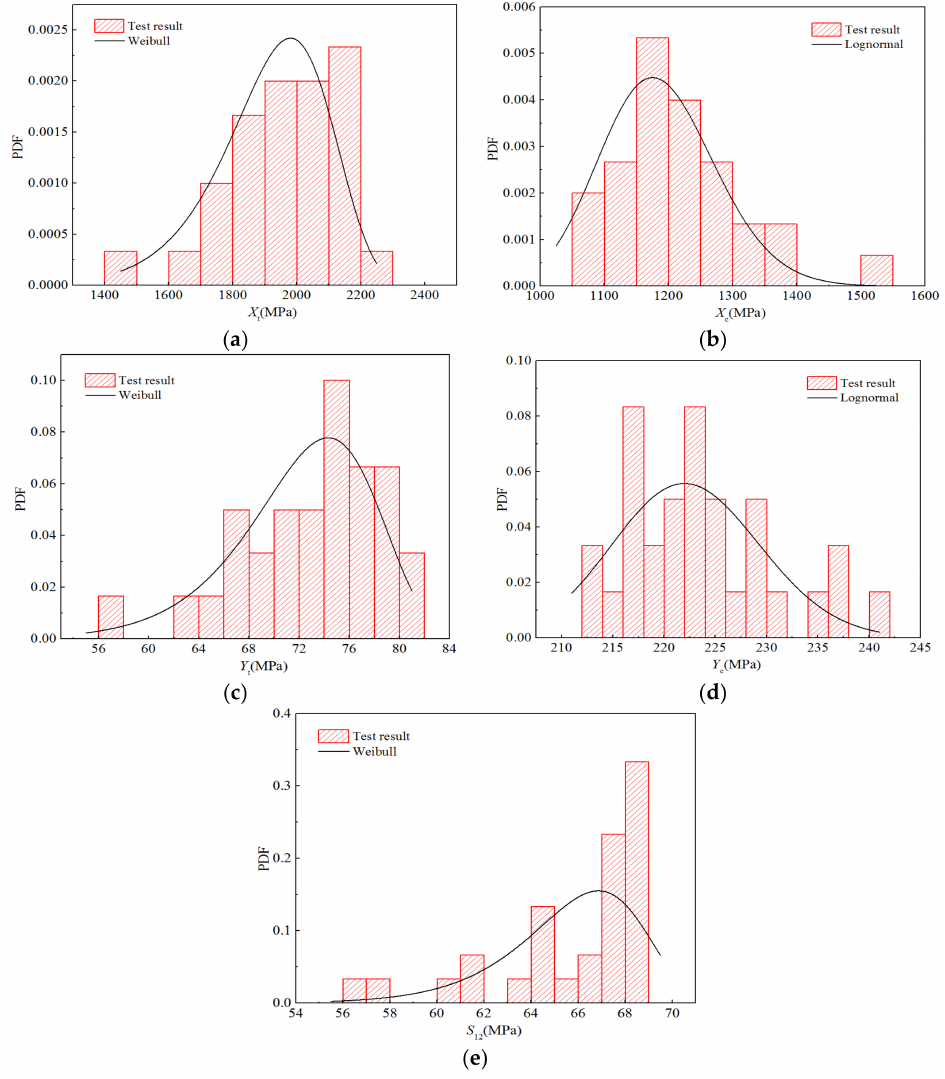
Figure 9. Probability distribution diagrams for the strength properties of H-GFRPs under the RTD condition. ( a ) X t , ( b ) X c, ( c ) Y t , ( d ) Y c, ( e ) S 12